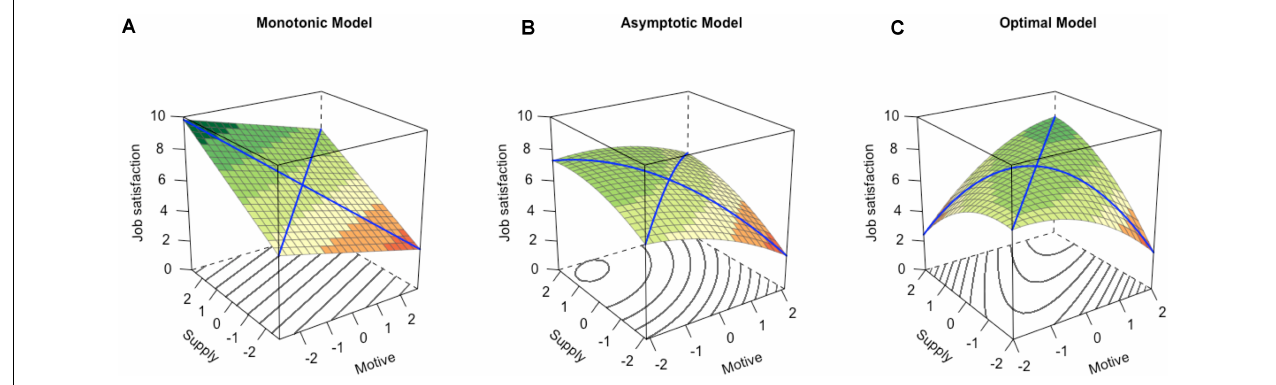
FIGURE 1 | Prototypical response surfaces displaying the (A) monotonic, (B) asymptotic, and (C) optimal models. The vertical axis indicates the level of job satisfaction for different combinations of the motive (right axis) and the supply (left axis). Higher numbers and darker shades of green represent higher levels of job satisfaction. Oversupply (i.e., supply > motive) is displayed along the left edge and undersupply (i.e., supply < motive) is represented along the right edge of each